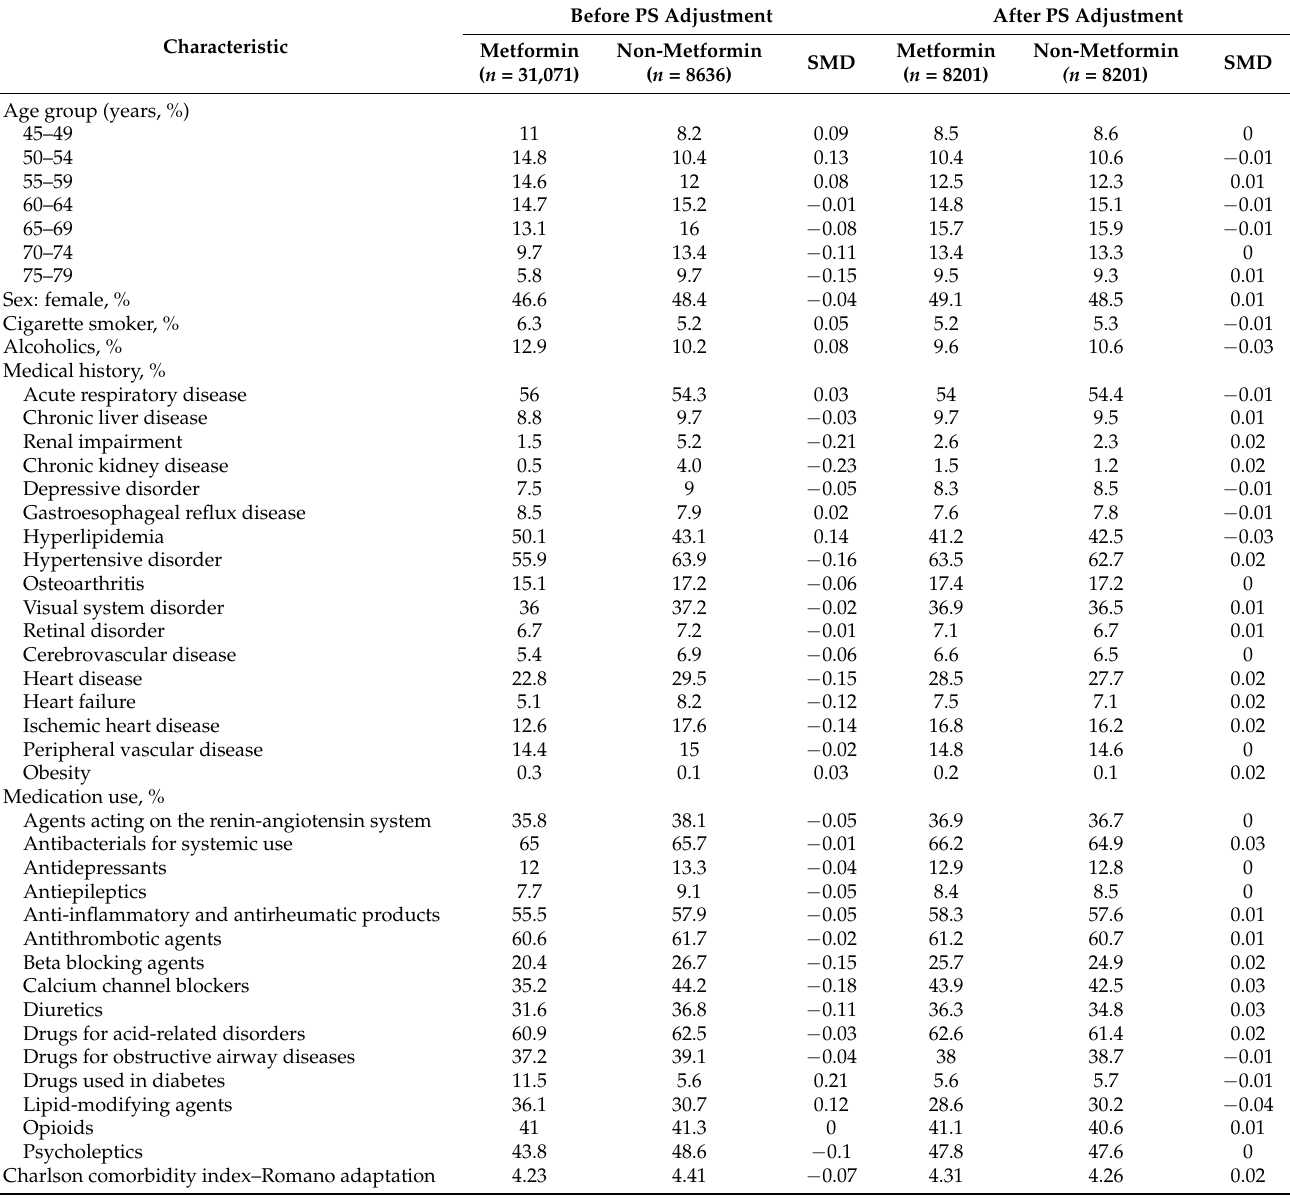
Table 1. Baseline characteristics between metformin users and non-users in the analysis of CRC inci-